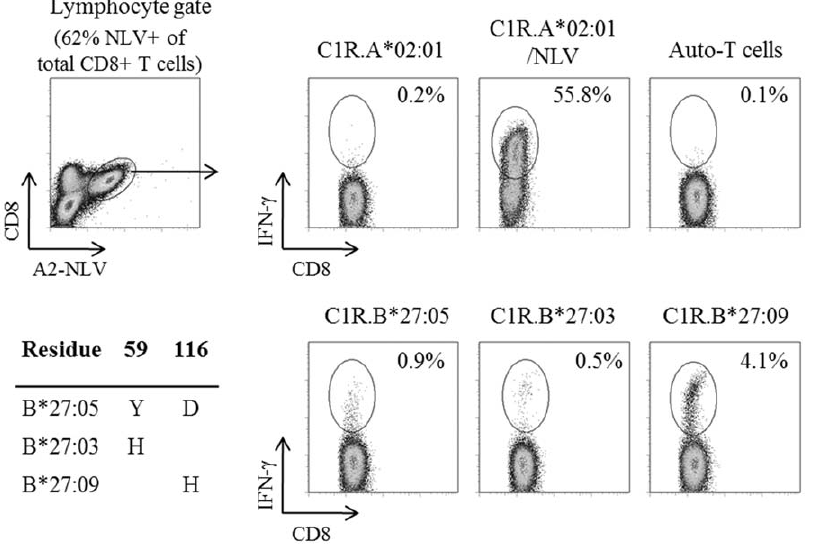
Figure 3. Influence of cross-reactivity by B27 allelic subtypes. Site-directed mutagenesis of the pMIG.B*27:05 vector was performed to generate B*27:03- and B*27:09-specific retroviruses for transducing C1R Parental cells. Comparison of cross-reactive NLV-specific IFN- c responses between B*27:05, B*27:03 and B*27:09 was then carried out following a 6 hour stimulation and ICS assay of day 13 NLV-specific CD8 + T cells (HC5) with the B27-specific cell lines as well as positive (C1R.A*02:01/NLV) and negative controls (C1R.A*02:01, Auto-T cells).